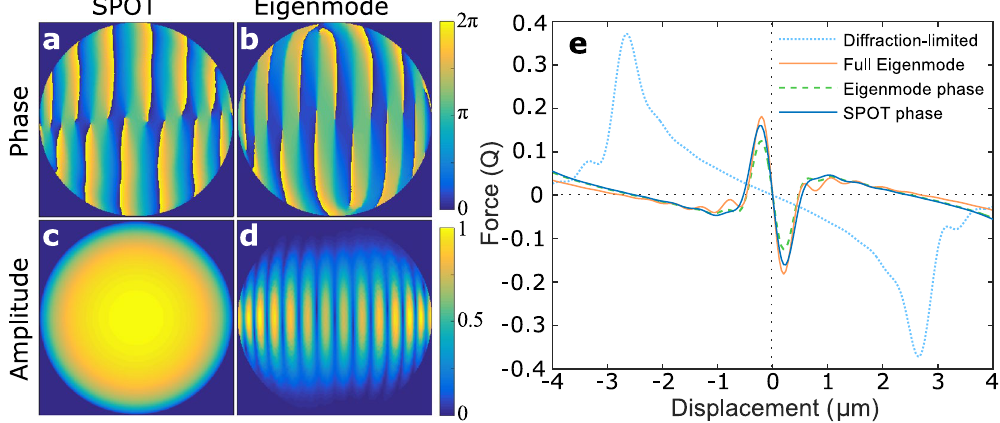
Figure 2. Comparison of the SPOT wavefront and the optimal wavefront calculated with the Eigenmode method, for 5 μ m diameter silica (n = 1.46) microspheres in water trapped with circularly polarize light. ( a , b ) The phase profiles of both methods include vortices; and as the Eigenmode solution is globally optimal, this must allow higher stiffness than a fully continuous phase profile. SPOT requires only a standard Gaussian amplitude ( c ), while the Eigenmode solution requires detailed amplitude structure ( d ). ( e ) The resulting trapping forces as a function of displacement. Sharp and narrow trapping features replace the wide profile of the diffraction-limited Gaussian. This increases trap stiffness without increasing the maximum achievable force. As expected the Eigenmode solution with full wavefront control provides highest stiffness, though phase-only control allows close to the same performance. Application of the Eigenmode phase ( b ) with Gaussian amplitude ( c ) provides the closest approximation to the fully optimal wavefront possible with phase-only control; however, it is clearly out-performed by our SPOT